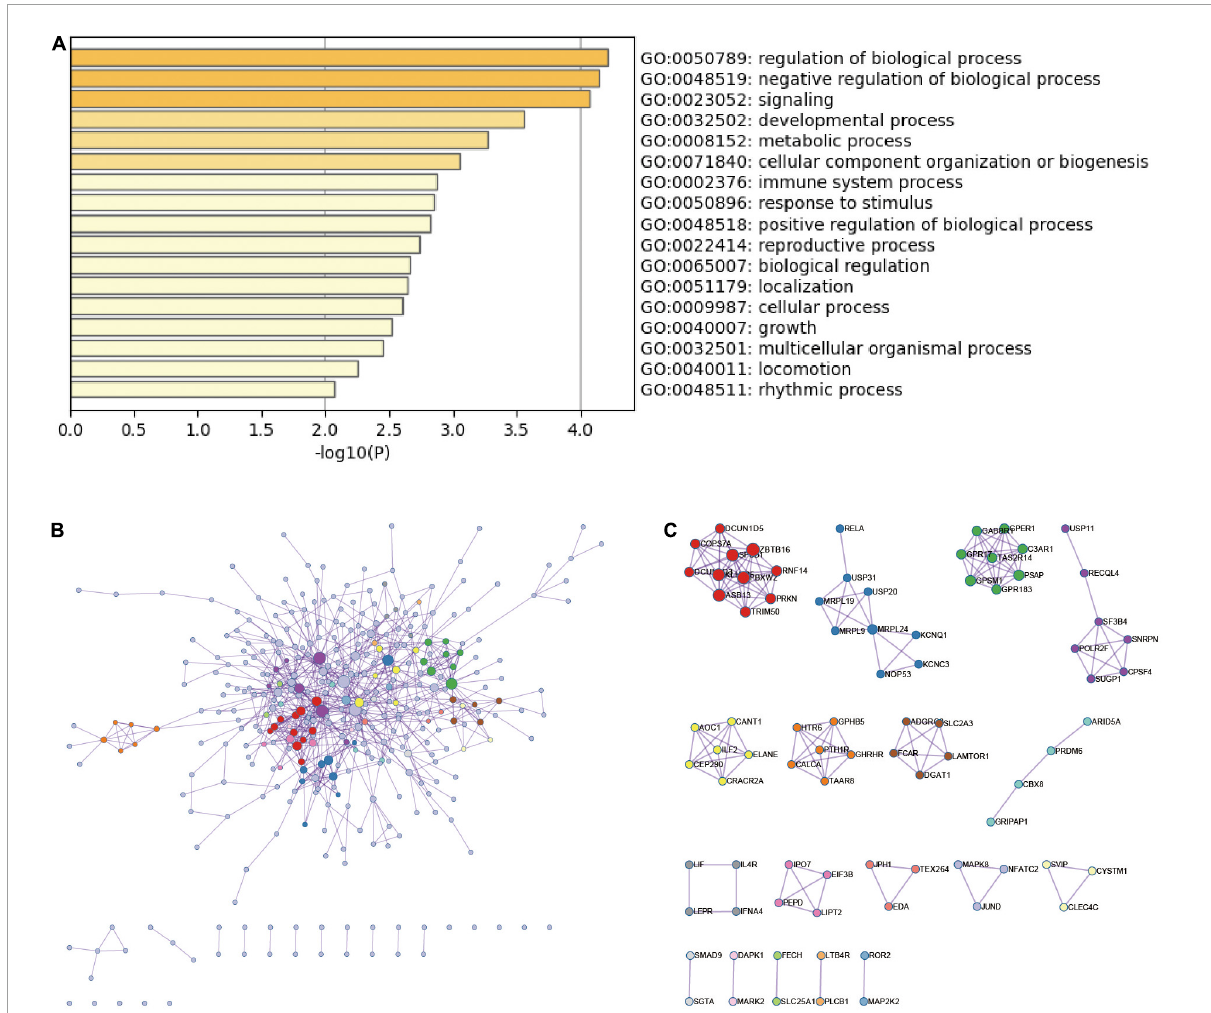
FIGURE3 Functional enrichment analysis and PPI network of DEmRNAs in ICH. (A) The top-level Gene Ontology biological processes of DEmRNAs in ICH. (B) PPI network of DEmRNAs in ICH group and MCODE component in gene table. (C) The main protein interaction domains extracted from the protein